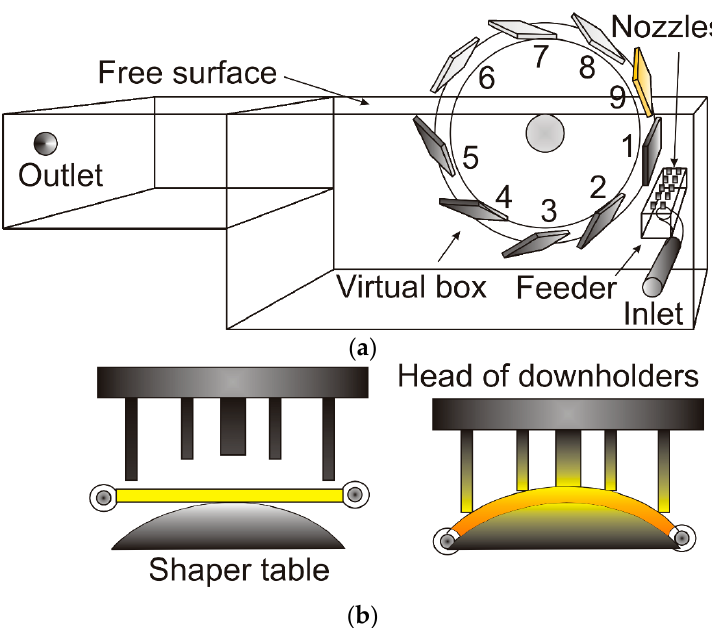
Figure 2. ( a ) Schematic representation of the oil quenching tank. Carousel is fed with leaf springs at position 9. ( b ) Sequence for shaping a leaf spring before immersion in the tank. Table 4. Dimensional specifications of the quenching system.